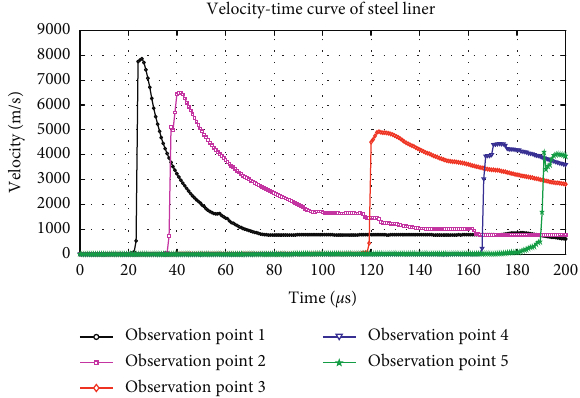
Figure 8: SCJ velocity curve of the steel